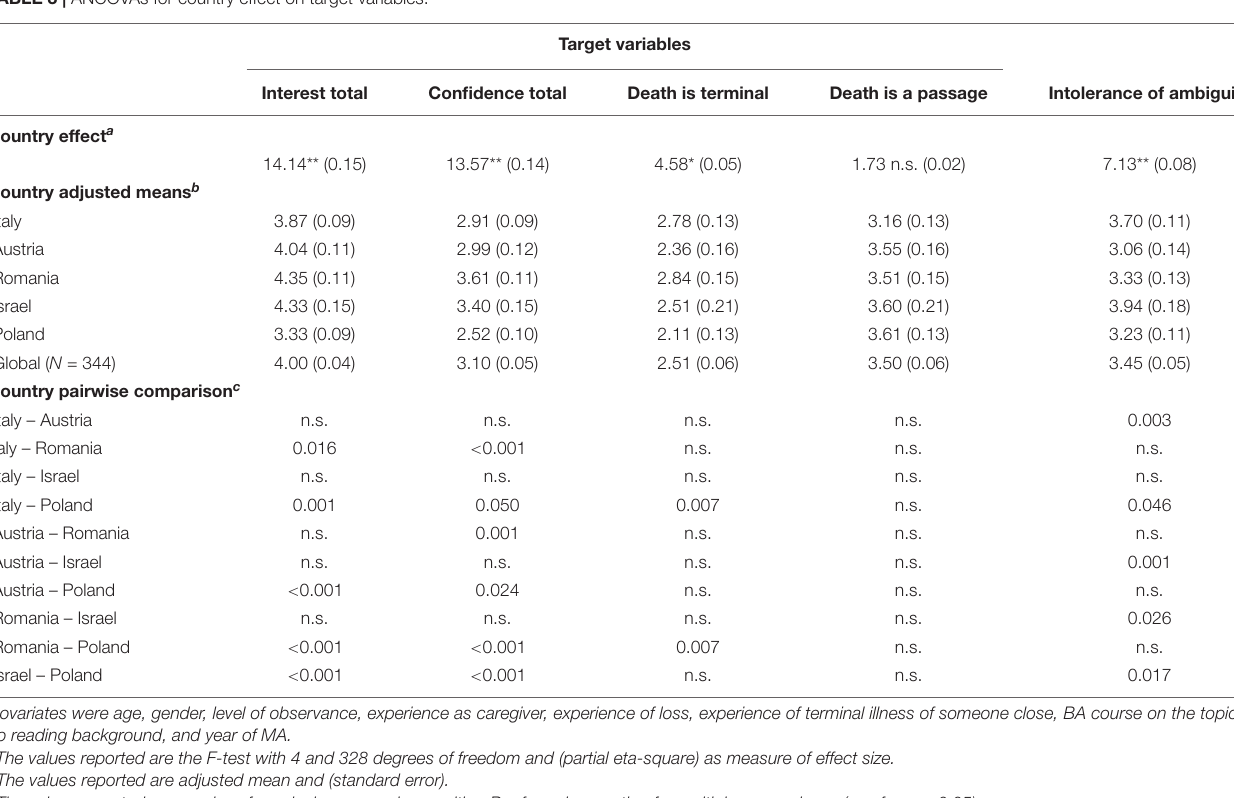
TABLE 3 | ANCOVAs for country effect on target variables.